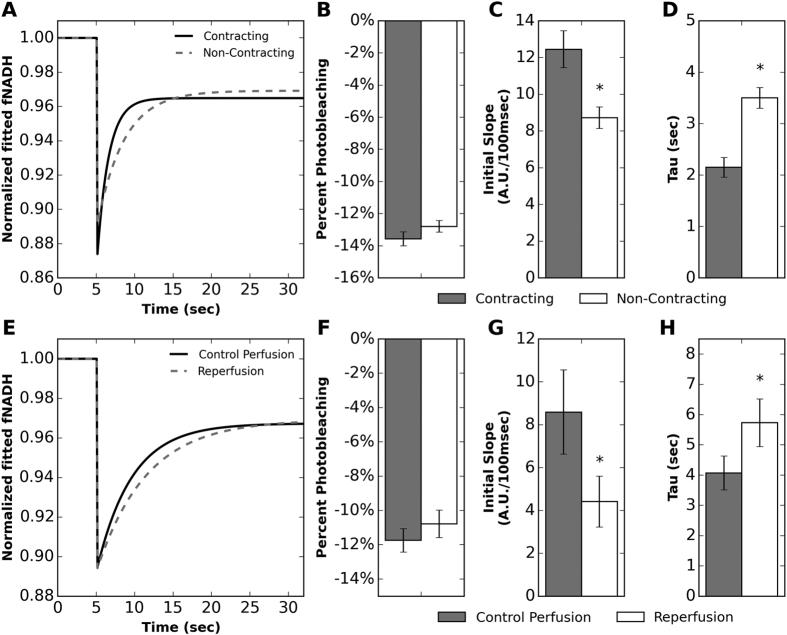
NADH ED-FRAP measurements (LP mode) showing the effect of contraction (top row) and ischemia/reperfusion (bottom row) on the rate of NADH production in perfused hearts.(A) Representative fNADH data were fitted (‘y’ in Equation 4) and plotted for NADH ED-FRAP applied to contracting hearts and non-contracting hearts electromechanically uncoupling with BDM. (B) Percent photobleaching was not significantly different between contracting and non-contracting hearts (p > 0.05, n = 6). (C) The initial slope of fNADH recovery was significantly higher in contracting hearts (p = 0.015, n = 6). (D) The time constant of fNADH recovery (tau) was significantly shorter in contracting hearts (p < 0.001, n = 6). (E) Representative fNADH data were fitted (‘y’ in Equation 4) and plotted for NADH ED-FRAP applied before ischemia and 10 min after reperfusion. Hearts were electromechanically uncoupled with BDM. (F) Percent photobleaching was not significantly different before ischemia and after reperfusion (p > 0.05, n = 5). (G) The initial slope of fNADH recovery was significantly lower after reperfusion (p = 0.04, n = 5). (H) The time constant of fNADH recovery (tau) was significantly longer after reperfusion (p = 0.049, n = 5).